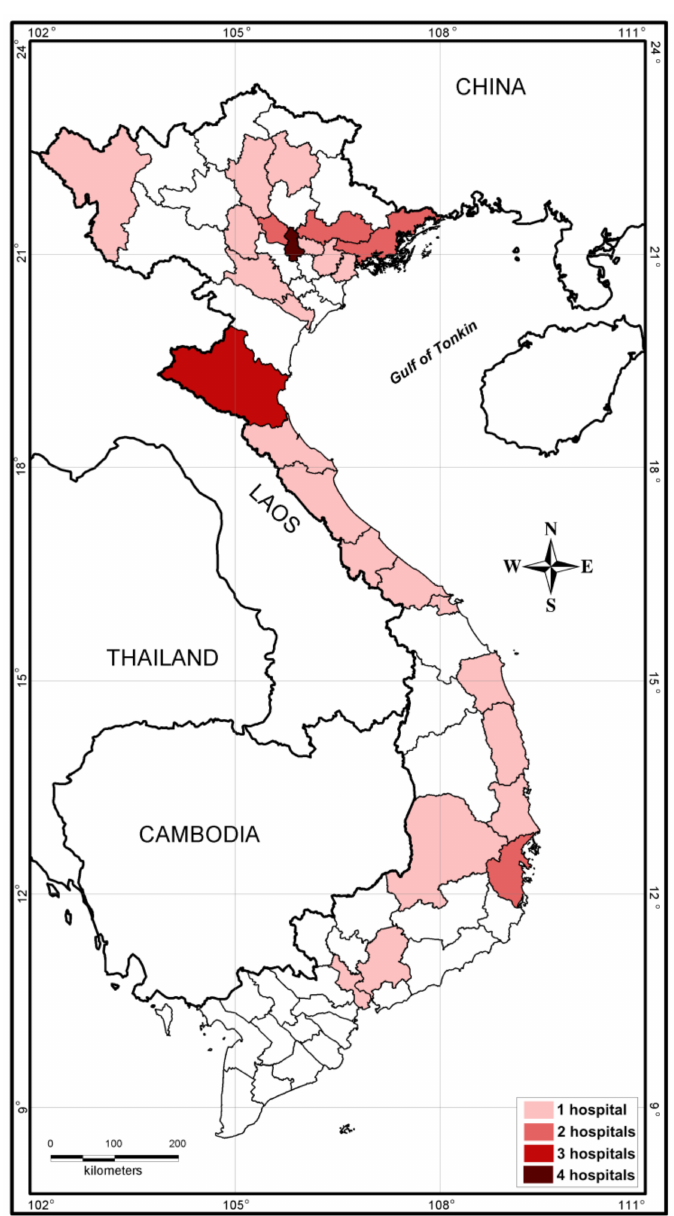
Figure 1. Location of hospitals taking part in the RENOMAB project and reporting culture-confirmed melioidosis cases. All of the B. pseudomallei strains were sent to the reference laboratory at the Institute of Microbiology and Biotechnology, Vietnam National University, Hanoi. B. pseudomallei identification of bacterial strains was confirmed by using either recA sequence analysis or B. pseudomallei -specific TTSS1 real-time PCR assay [28]. Border lines of provinces or cities are shown. The color indicates the number of hospitals within the province or city that reported cases of melioidosis. Geographic map was constructed by the MapInfo 7.8 (MapInfo, Troy, NY,